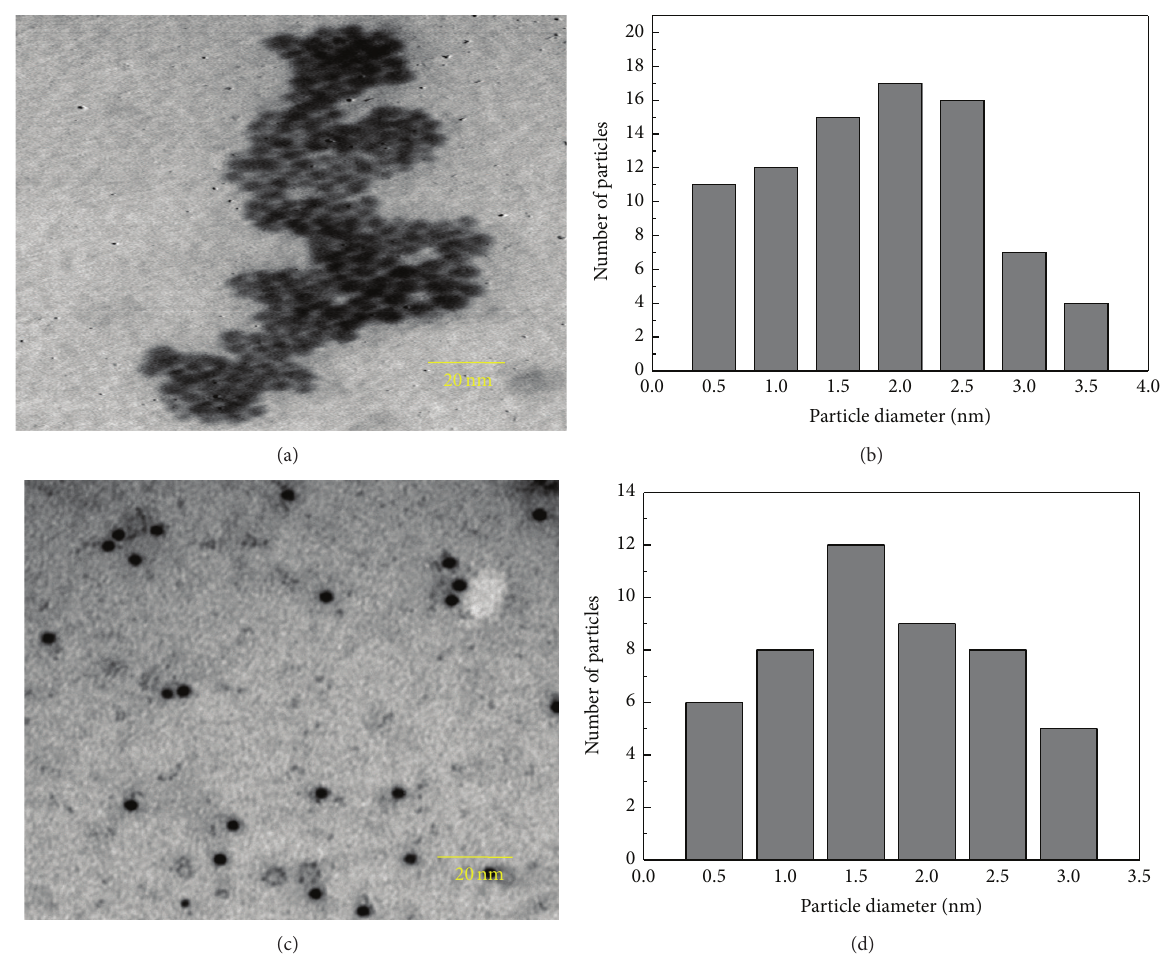
Figure 5: TEM images and the particle size histograms of the (a) and (b) CdTe-TGA QDs and (c) and (d) CdTe-salep-g-PAA QDs.